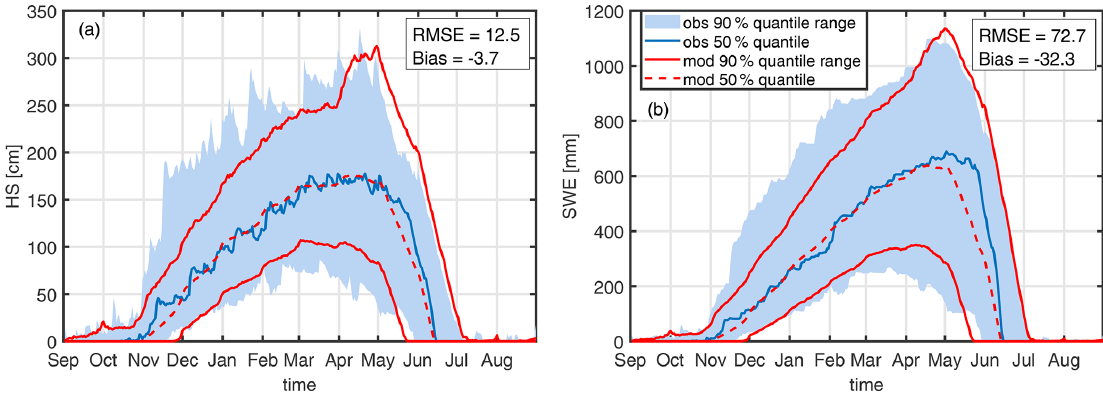
Figure 5. Snow depth measured (a) and SWE (b) derived by an HS2SWE model (blue) at station OBW 2. Plotted are the 5th, 50th and 95th percentiles of 20 years of observations (obs) and 1500 years of weather-generator snow model data (mod). RMSE and bias are calculated for 50th-percentile values and for days when either the model or the observations show positive